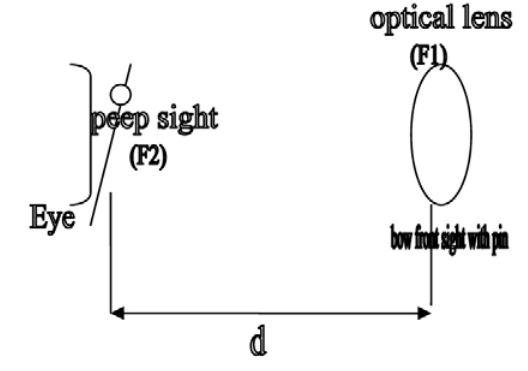
Figure 2 . Illustration of the two lens